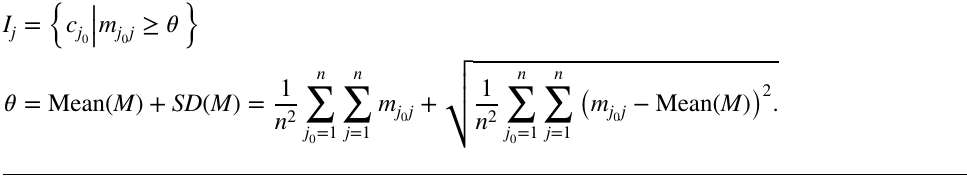
Then, we obtain the center factors R j − D factors R j j 0 . 0 Step 3. Obtain the set of criteria interaction I j for crite- rion j .